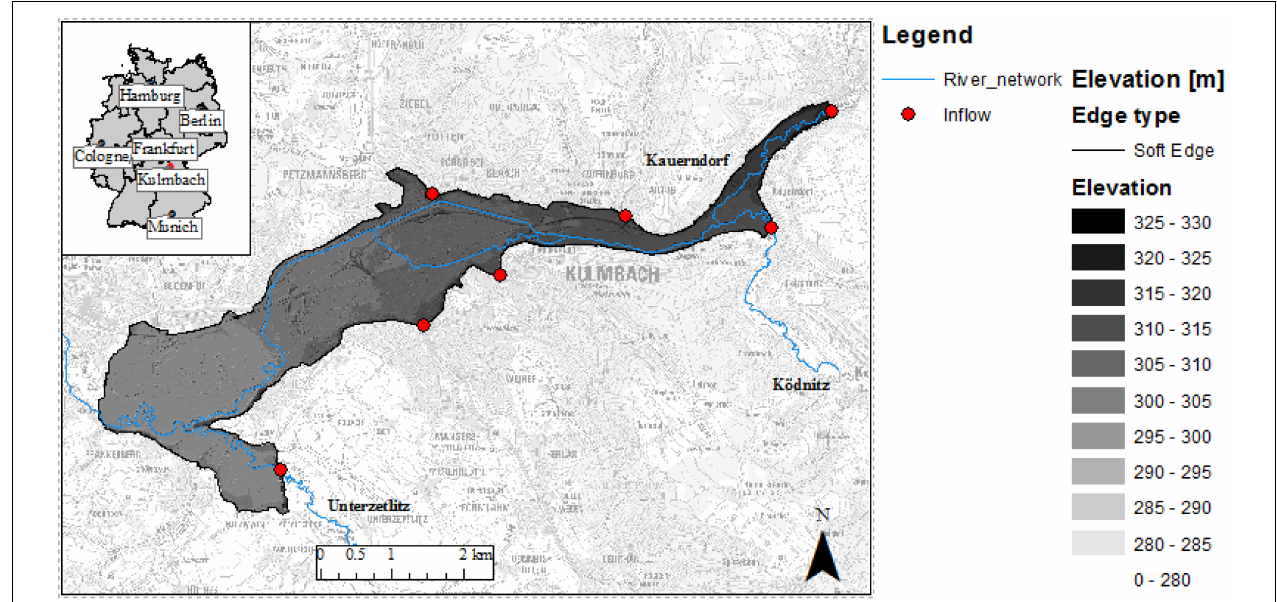
FIGURE 2 | Map of the study area. It shows the location of Kulmbach in Germany. The blue curves represent the river network. The shaded region is the study area with its topography represented. On the marked boundary, the red points represent the seven inflow boundary conditions (three rivers and four smaller